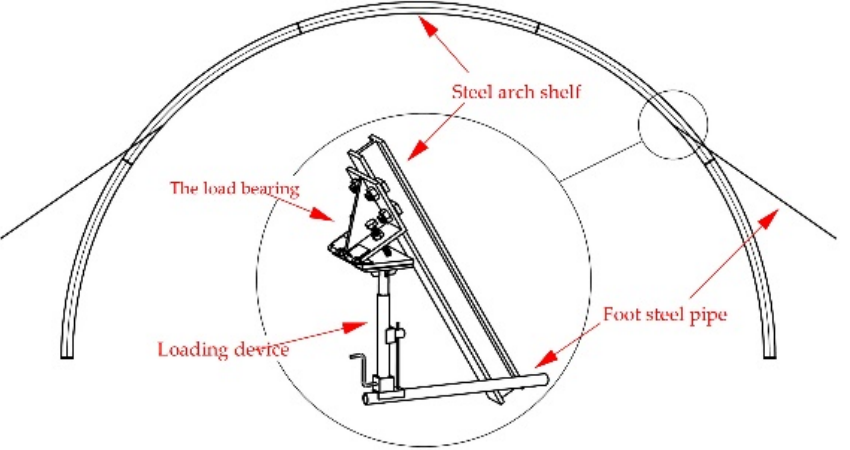
Figure 19. Detail drawing of loading device.